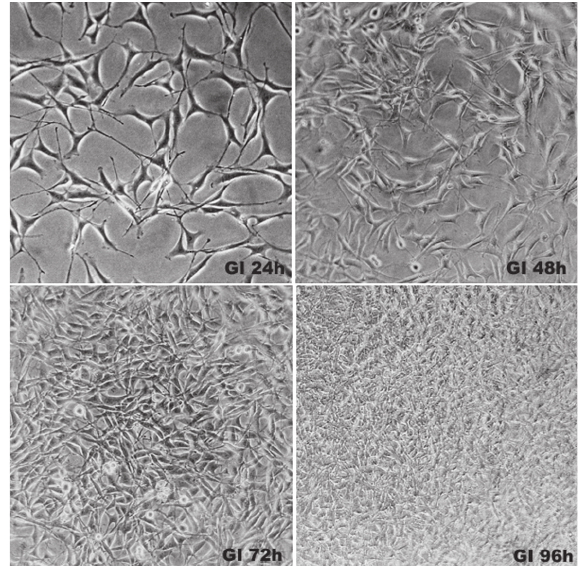
Figure 3- ;."%"<$5&"'&+=., "> ?&"9= @@ 08$=&":"A+5$#2